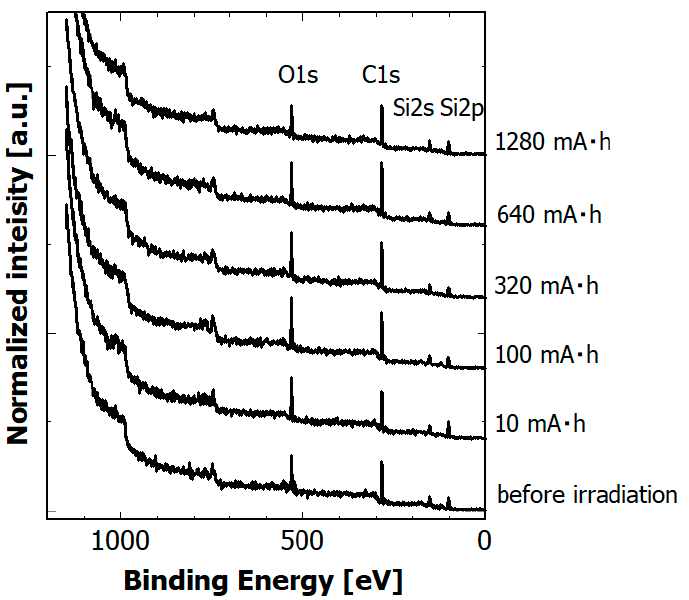
Figure 7. Dependence of XPS spectra of hydrogenated Si-DLC films on SR dose. surface are plotted in Figure 8. The black, green, and red circles respectively show